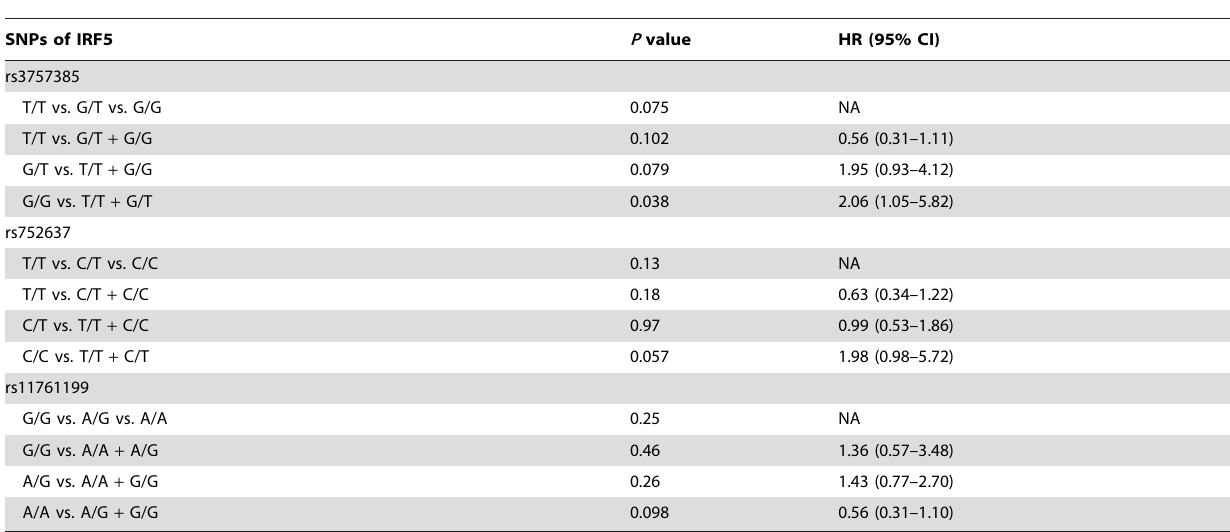
Table 4. Comparison of survival curves among SNP